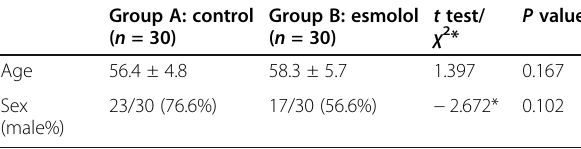
Table 1 Comparison between both groups according to the demographic data